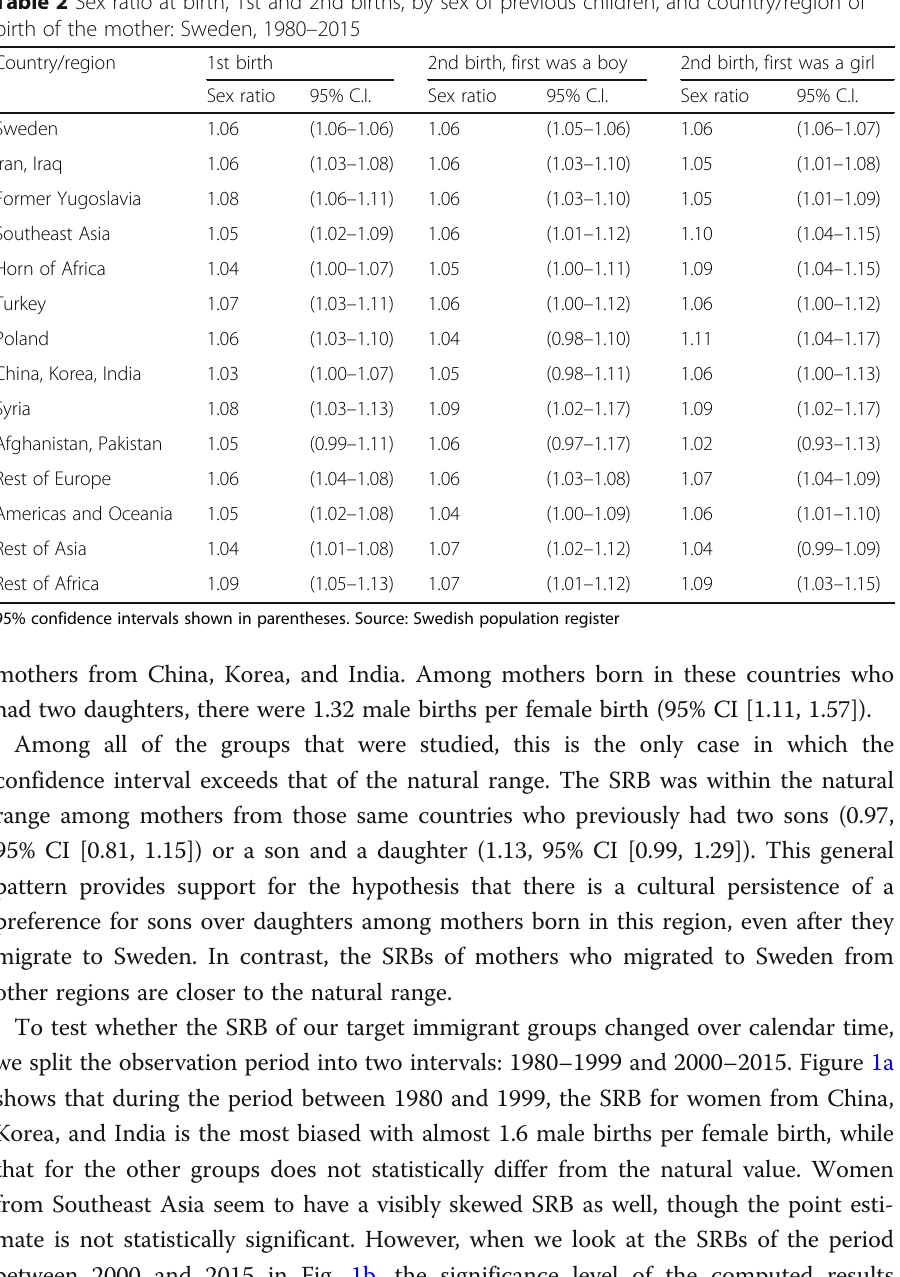
Table 2 Sex ratio at birth, 1st and 2nd births, by sex of previous children, and country/region of birth of the mother: Sweden, 1980 – 2015 Country/region